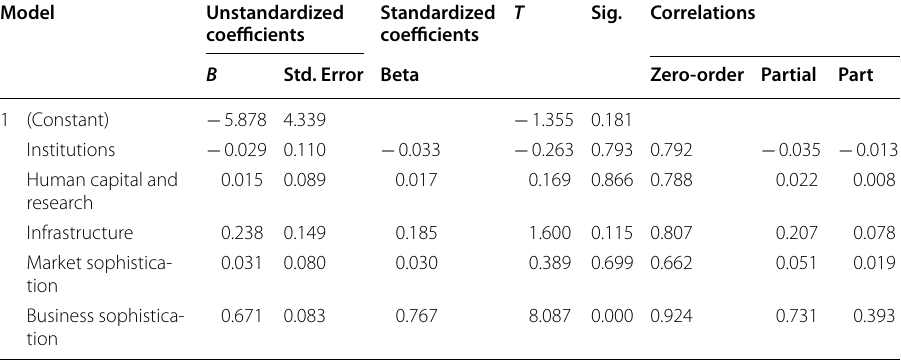
Table 4 Regression coefficients of pillar innovation inputs and innovation output